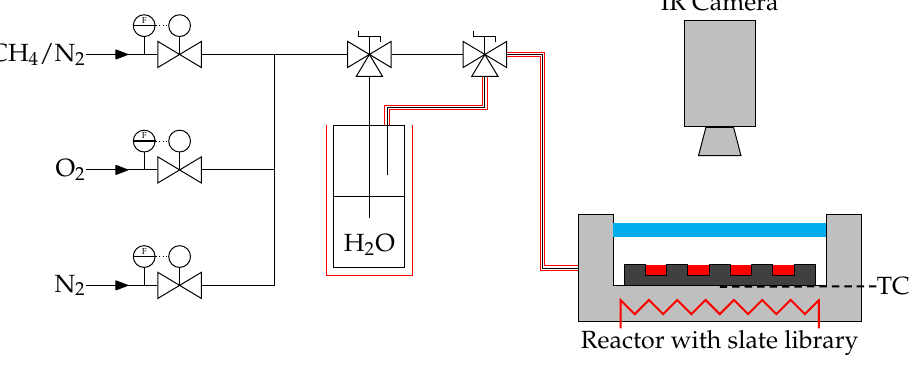
Figure 19. Schematic process diagram for ecIRT